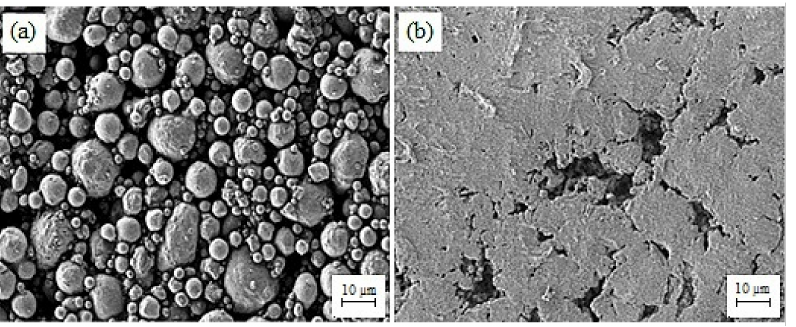
Figure 6. FESEM images of the ( a ) 17-4PH and ( b ) zirconia portions of the micro-sized 17-4PH/zirconia component after thermal